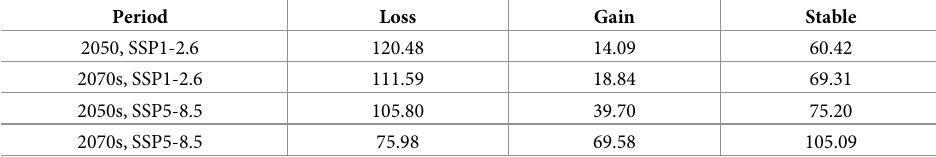
Table 3. Future changes of P . tatarinowii in suitable habitat area (10 4 km 2 ).